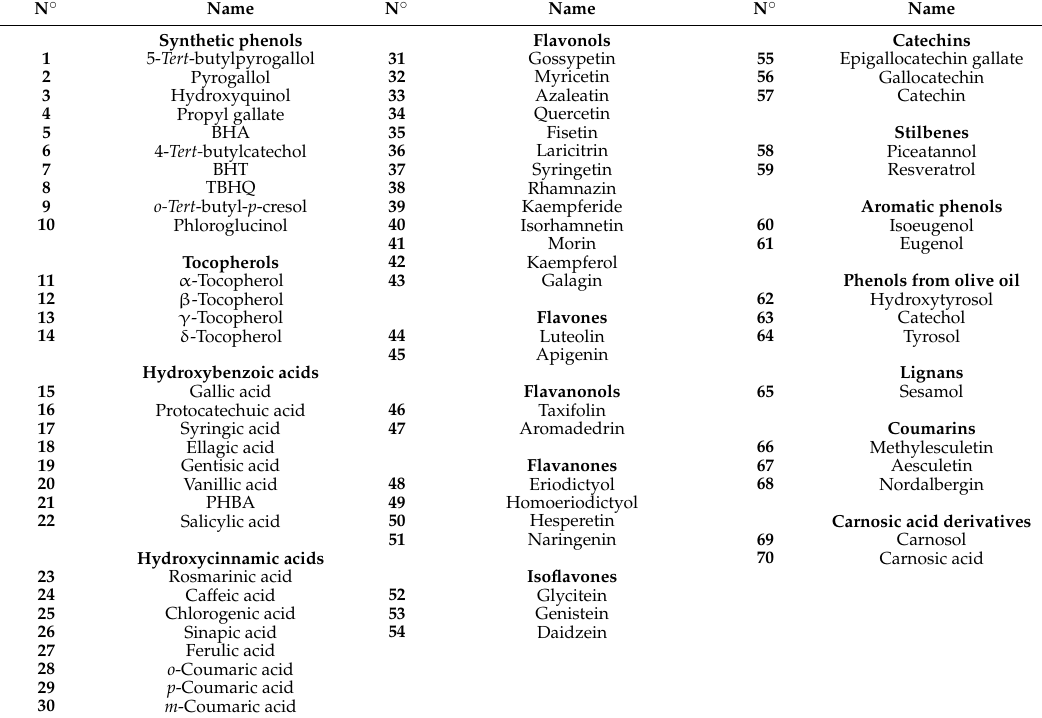
Table 1. Names and numbers of the polyphenols studied in this work.